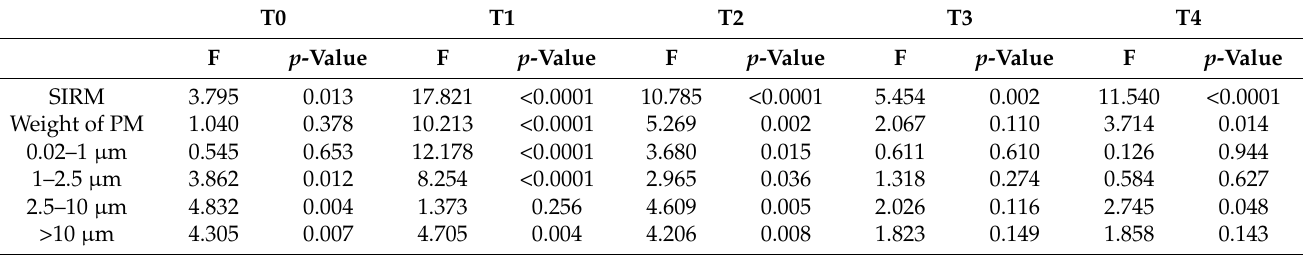
Table 1. Results (SIRM, weight of PM, and different grain-size particles (0.02–1 µ m, 1–2.5 µ m, 2.5–10 µ m, and >10 µ m)) of one-way ANOVA performed between four sampling directions (NE, SW, NW, and SE) at sites T0–T4. Statistically significant differences ( p < 0.05) are highlighted in